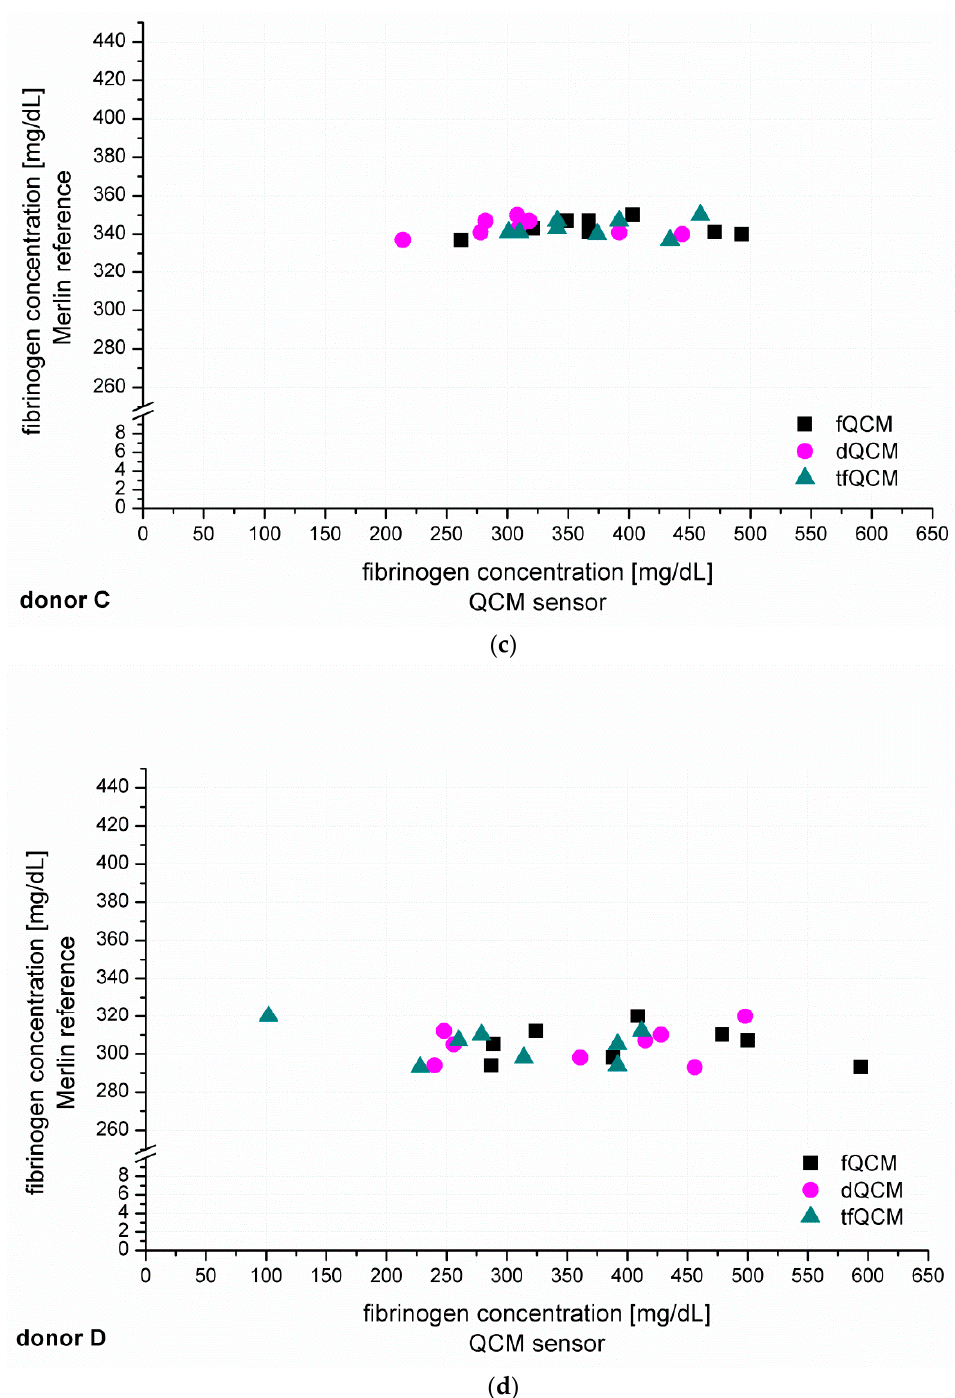
Figure 4. Cont . Figure 4.